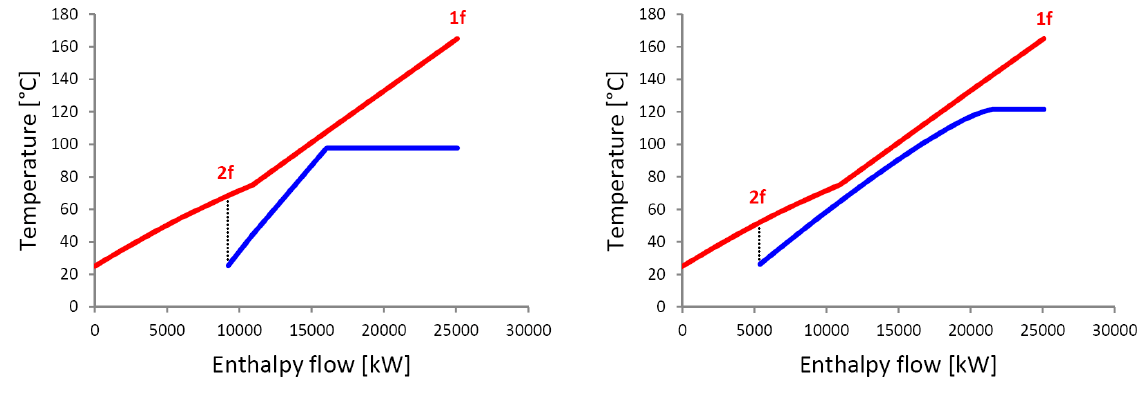
Figure 6. Almost dry resource composite curves. ( a ) R-245fa solution; ( b ) R-236fa